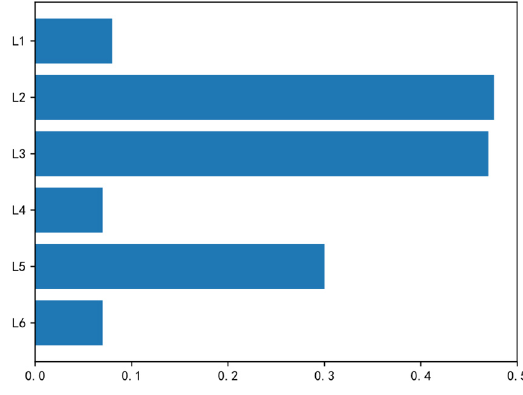
Figure 12. Lerner index of individual generators.